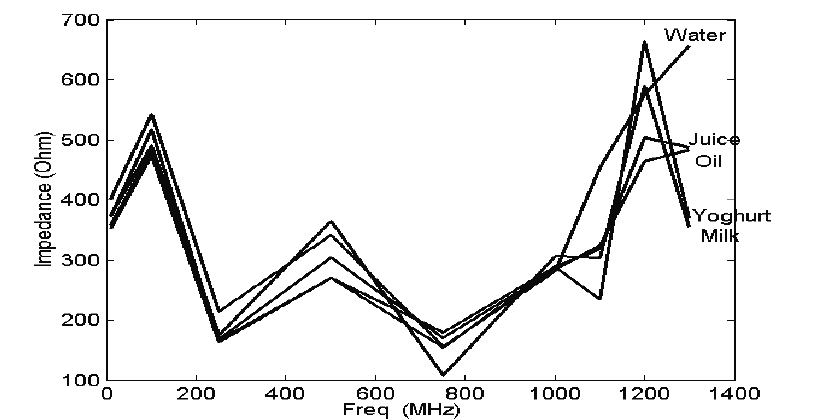
Figure 30. The impedance magnitude as a function of frequency for different dielectric materials.